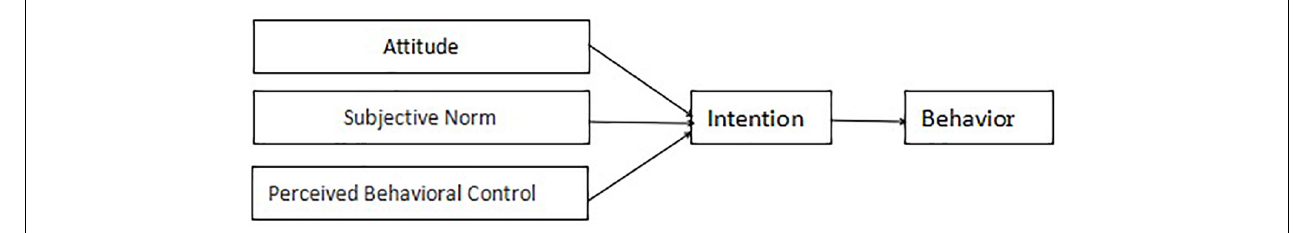
FIGURE 1 | Theoretical model of planned